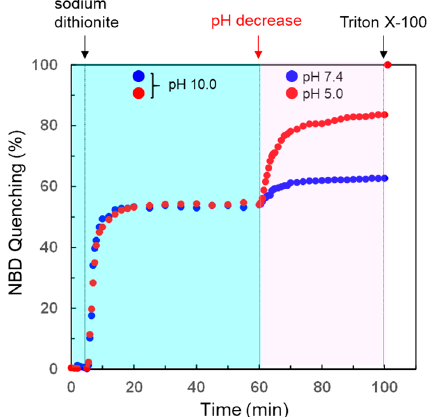
Figure 7. Membrane lytic activity of the liposomes anchoring the 1.0 mol% of rLPE-St characterized by the membrane accessibility assay. Membrane accessibility was estimated from quenching of NBD dye-labeled lipids by using a membrane-impermeable reductant sodium dithionite. Measurements were carried out at 25 °C.